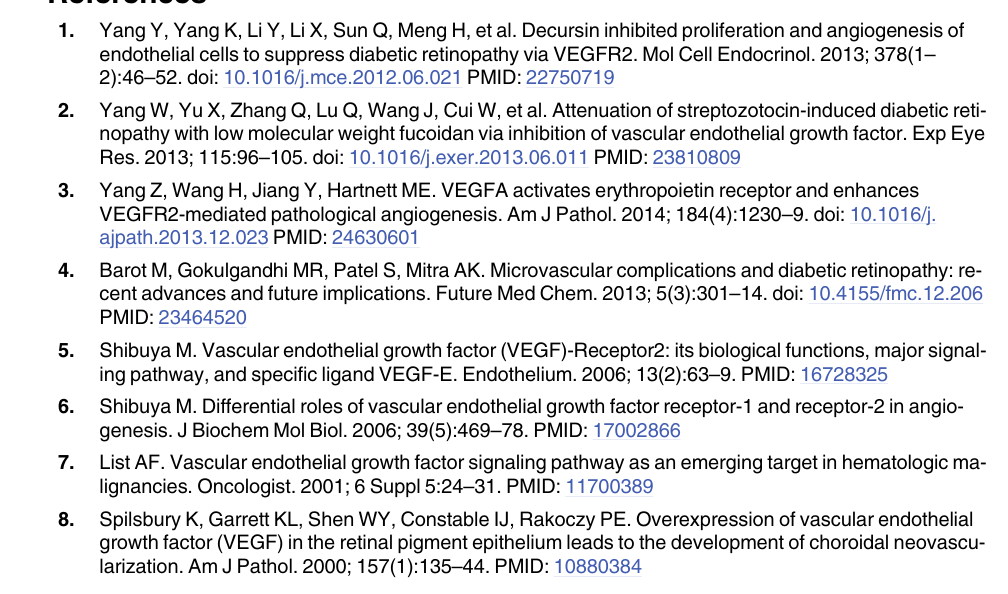
S1 Table. Primer sequences used in Chromatin